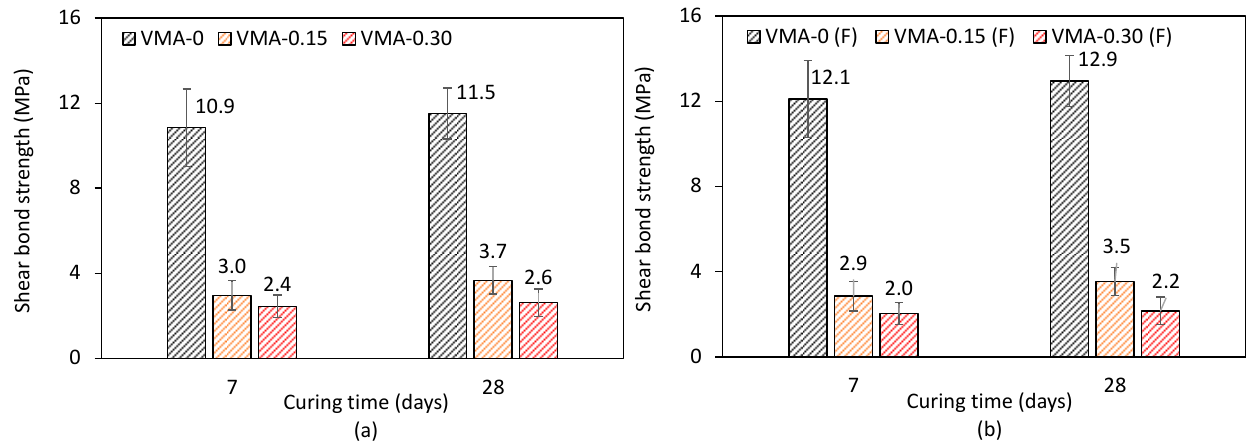
Figure 16. Shear bond strength of the extruded specimens for fiber-free ( a ) and fiber-reinforced ( b ) mixtures.